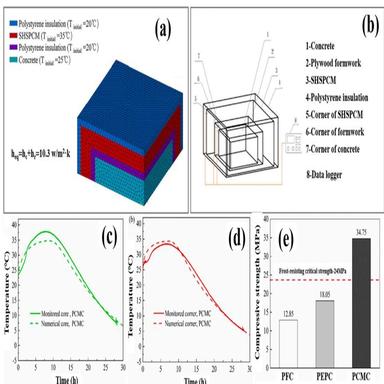
(a) Finite element model, mesh and thermal boundaries, (b) schematic of curing concrete structure using SHSPCM, the monitored and numerical core temperature (c) and corner temperature (d) variation within PCMC, and (e) compressive strength of the concretes under different curing methods . Reproduced with the permission of Elsevier.